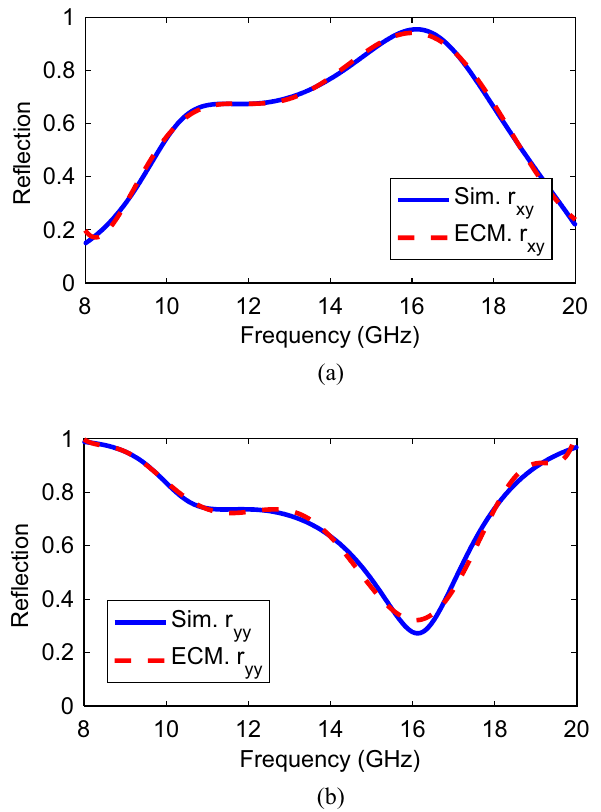
Figure 9. Simulated and equivalent circuit modelling of ( a ) Cross- and ( b ) Co-polarized reflection coefficient for y -polarized incident